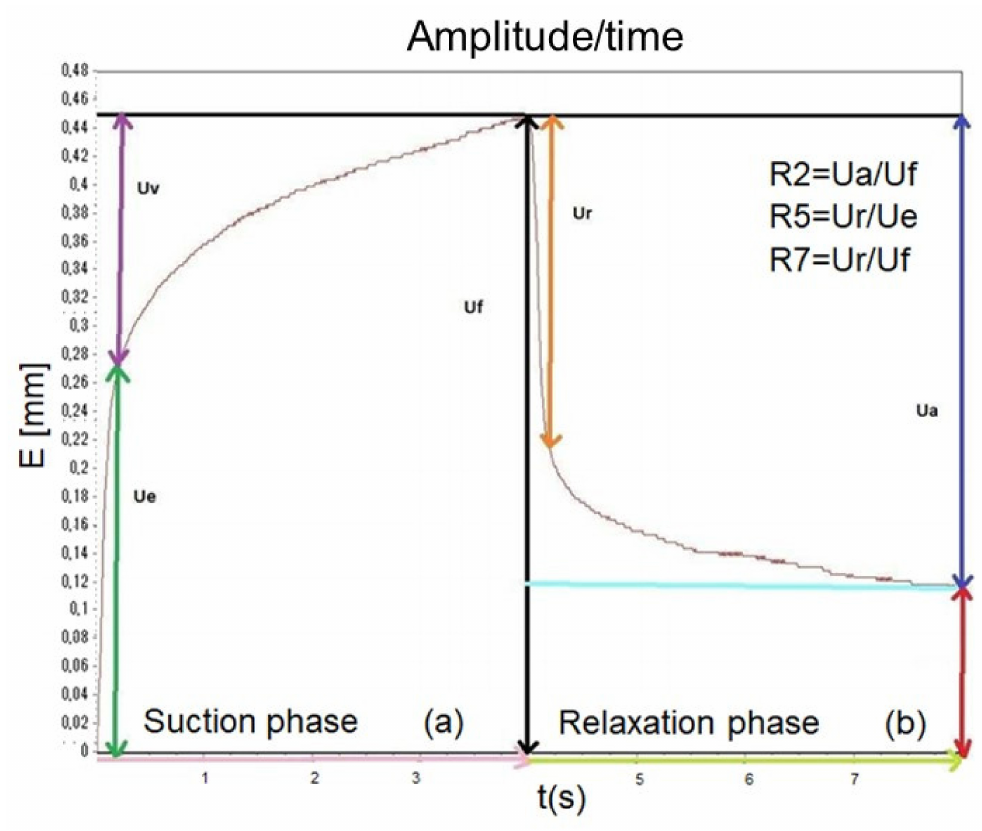
Figure 1. Strain–time curve (deformation, mm/time, s) obtained by Cutometer Dual MPA 580 used to extrapolated elasticity skin parameters (R2, R5, and